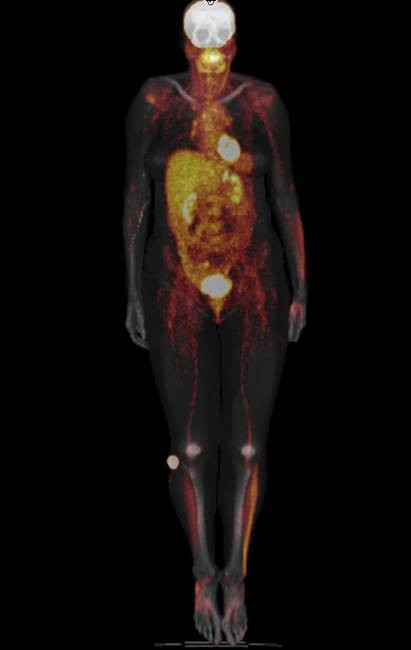
Metabolic imaging using whole body 18F-Fluorodeoxyglucose PET and CT. Note the metabolic activity on the lateral side of the left lower limb as well as on the right ankle. The area around the ankle corresponds to the Shen mai acupuncture point which has been evaluated in our study. Shank muscles are commonly more active in locomotion. The image was provided courteously by Dr David Townsend, University of Tennessee [165].